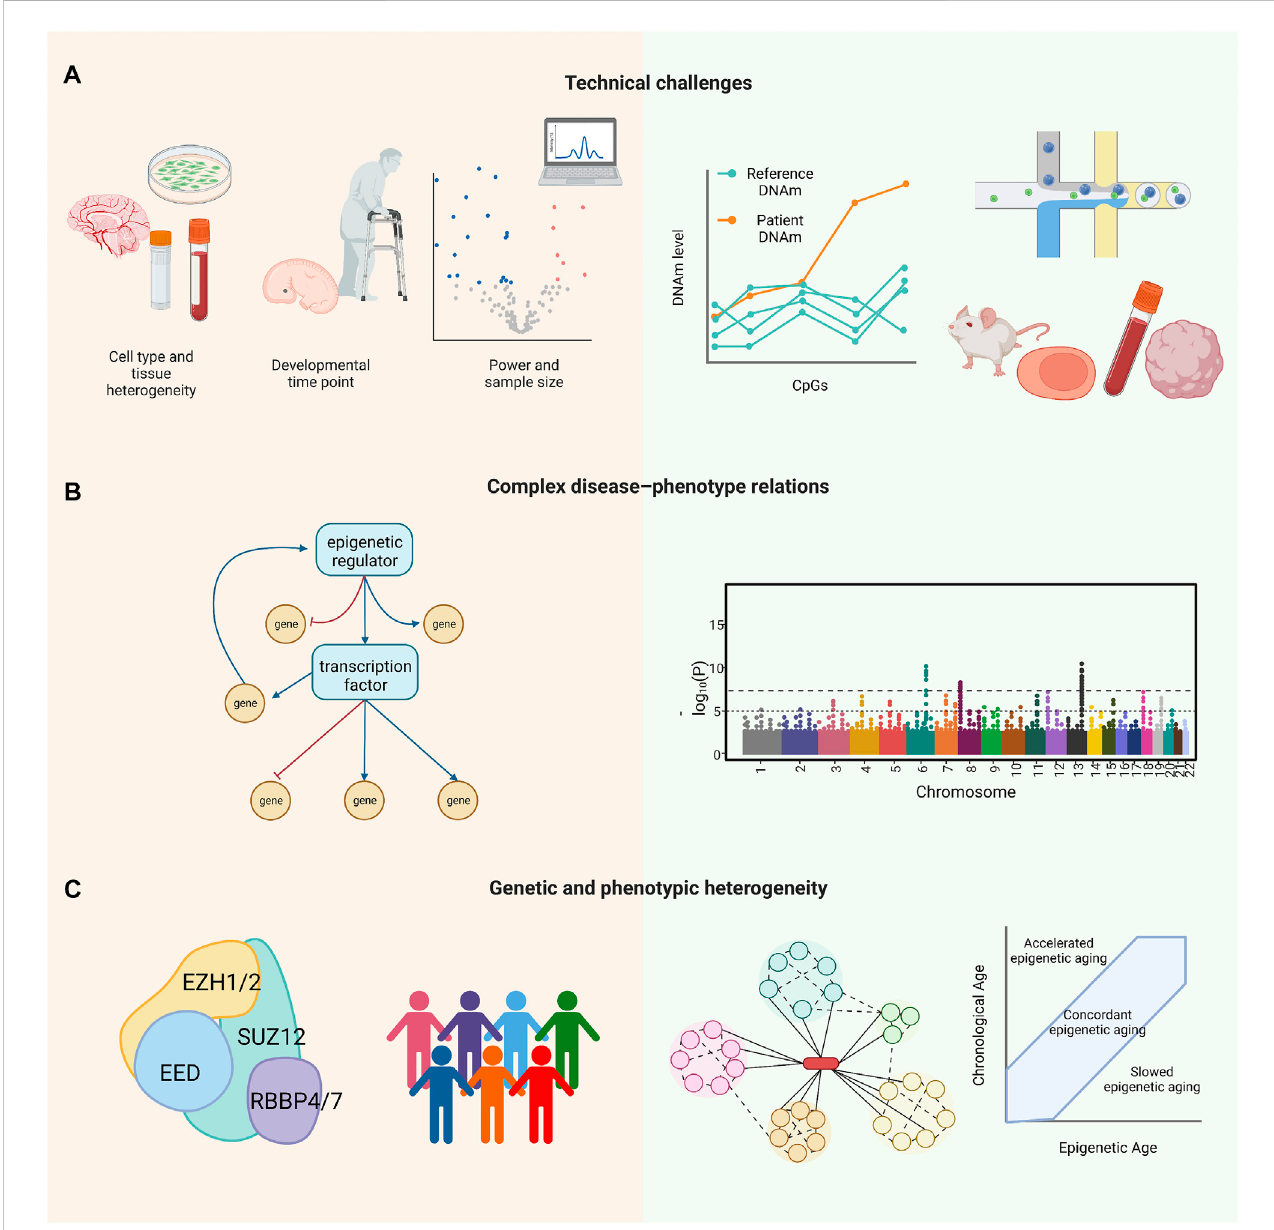
FIGURE 2 Challenges(leftpanel)andopportunities(rightpanel)inRDEOresearch. (A) Technicalchallengesincludesmallsamplesizeandlowstatisticalpower,cell type heterogeneity, and speci fi cities of developmental time points. Example solutions include a reference epigenome, single-cell epigenomic pro fi ling, and relevant RDEO models, such as animal models, primary samples, iPSCs, and organoids. (B) RDEOs often present with complex disease – phenotype relations, as the variants driving the RDEOs can drive widespread epigenetic dysregulation. Approaches such as RNA-Seq and EWAS can help to identify affected downstream elements and allow investigation of the mechanisms underlying the RDEO phenotype. (C) RDEOs commonly present with genetic and phenotypic heterogeneity. As an example of RDEO genetic heterogeneity, PRC2-related overgrowth syndromes are a group of RDEOs with a similar clinical phenotype all of which are linked to variants in PRC2. In contrast, patients with the same RDEO and variants in the same gene can have a range of clinical symptoms.Studiesofinteractingproteinsinthesamepathwaycanhelptodelineatethecomplexityofgeneticheterogeneity,andtoolssuchastheepigenetic clock may be applied to evaluate or monitor phenotypic heterogeneity. Abbreviations: CpGs, cytosine-guanine dinucleotides; DNAm, DNA methylation; RDEO, raredisease ofepigeneticorigin; EWAS, epigenome-wideassociationstudy; iPSC,inducedpluripotent stem cell;PRC2, Polycomb repressive